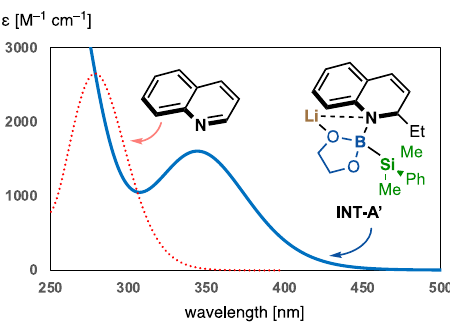
Fig. 2 | UV/vis absorption spectrum of INT-A ’ by TDDFT calculations. TDDFT Calculations were performed at B3LYP/6-31+G* levels of